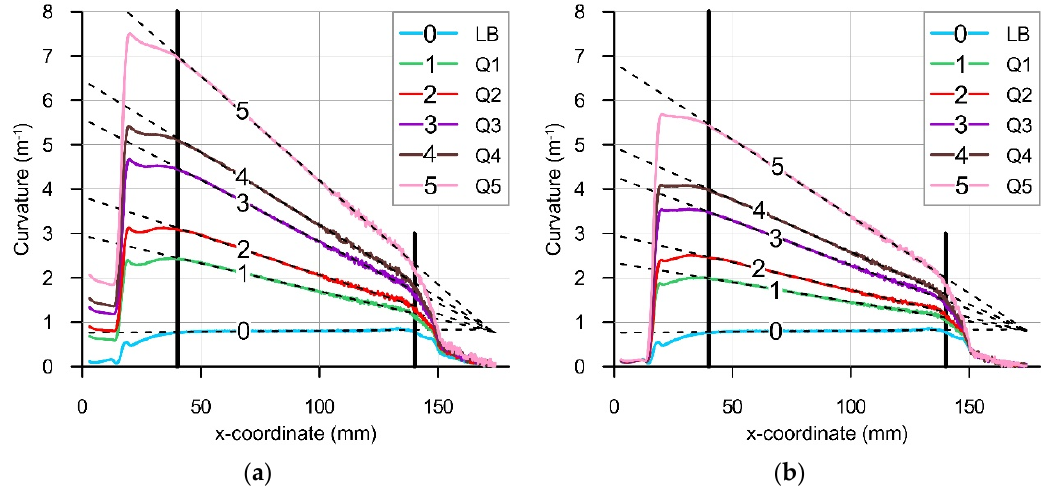
Figure 13. Curvatures of the beam axis in hybrid bending: ( a ) C L , ( b ) C F . The magnitude of the bending moment due to the own weight of the beam was calculated as M G ( x ) = q ( L − x ) 2 /2, where: q = ρ B H g is the distributed load, B is the beam width, and g is the acceleration due to gravity. Neglecting the influence of large deflections, the total mechanical bending moment can be calculated as M = M G + M Q , where the component due to the load Q is assumed M Q = Q ( L − x ) . The approximations of curvatures within the middle segments of linear change are presented in Figure 14